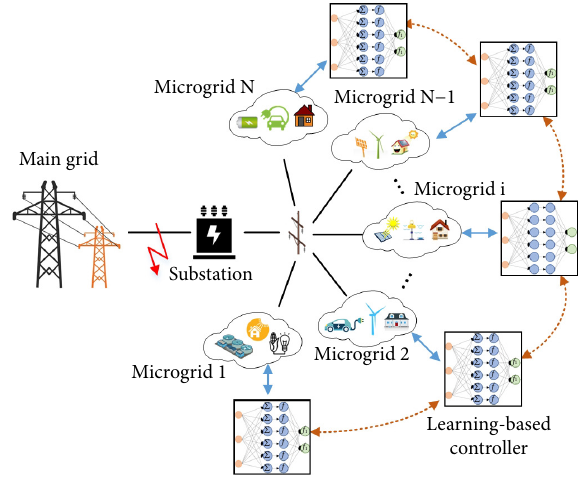
Fig. 1 Schematic of learning-based AFM for microgrids